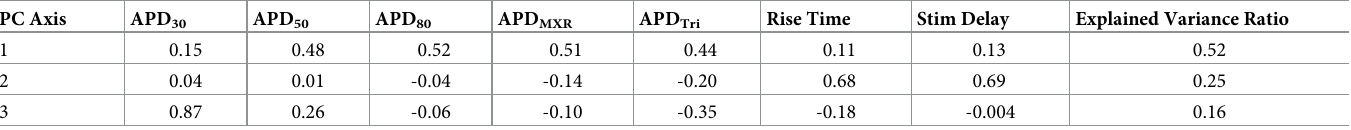
Table 3. Principal components analysis of experimental data using TTX, Flecainide, Nifedipine, and E4031 in Fig 8. PCA1 is a major axis that underlies overall APD prolongation and explains 52% of the variance. PCA2 mainly detects changes in rise time of the AP upstroke with a smaller contribution of APD tri and explains 25% of the variance.